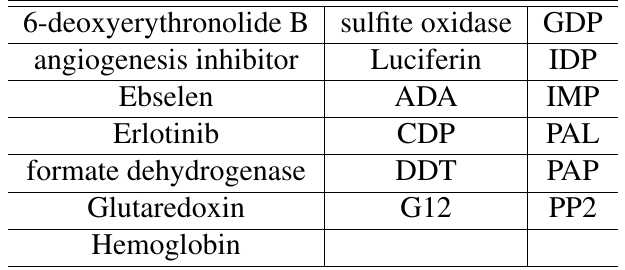
Table 3: Common terms between the BRENDA dictionary and ChEBI